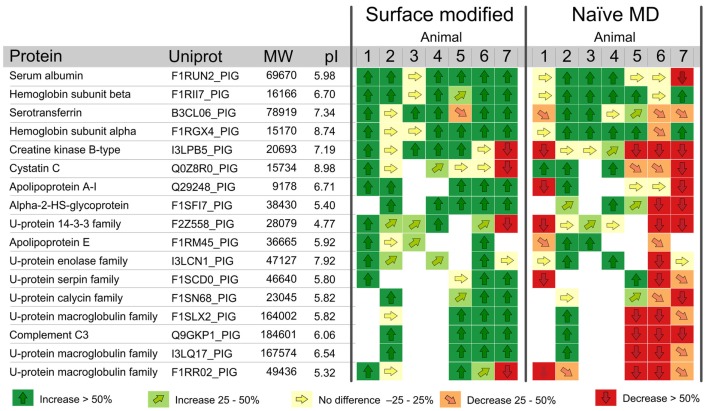
Protein response to ICP intervention for naïve and modified MD catheters. Vector diagram showing the response of the 17 most abundant proteins, according to the Mascot score (i.e., the probability that the experimental data set matches the database data) quantified in ≥4 animals, during step-wise intracranial hypertension. Proteins with vectors are relatively quantified. Proteins tagged with “Id” are identified but not quantified, i.e., fulfilling the identification criteria only. Proteins are presented with names, their Uniprot database number (www.uniprot.org), and their response to intervention for surface-modified and naïve catheters. The relative protein amount after intervention (Protein fraction 2, MD fractions 7–12) is compared with the relative protein amount from before intervention (Protein fraction 1, MD fractions 1–6). An arrow pointing straight up (↑) means that the particular protein has increased significantly in concentration by >50% due to the intervention. An arrow pointing straight down (↓) means that the concentration of the protein has decreased significantly by >50% in response to the intervention. Vectors pointing diagonally display either an increase (light green) or a decrease (orange) of 25–50%. These changes are not statistically significant but they show interesting tendencies. Finally, vectors pointing to the right (yellow) range between 0.75 and 1.25 and show no significant difference between the two fractions. U-protein means uncharacterized proteins. White boxes means that the protein was not identified or quantified in the sample. Thus, a white box is a reflection of the sample composition, not related to MD catheter performance (16). Reprinted with permission from Dahlin et al. (16). Copyright American Chemical Society.